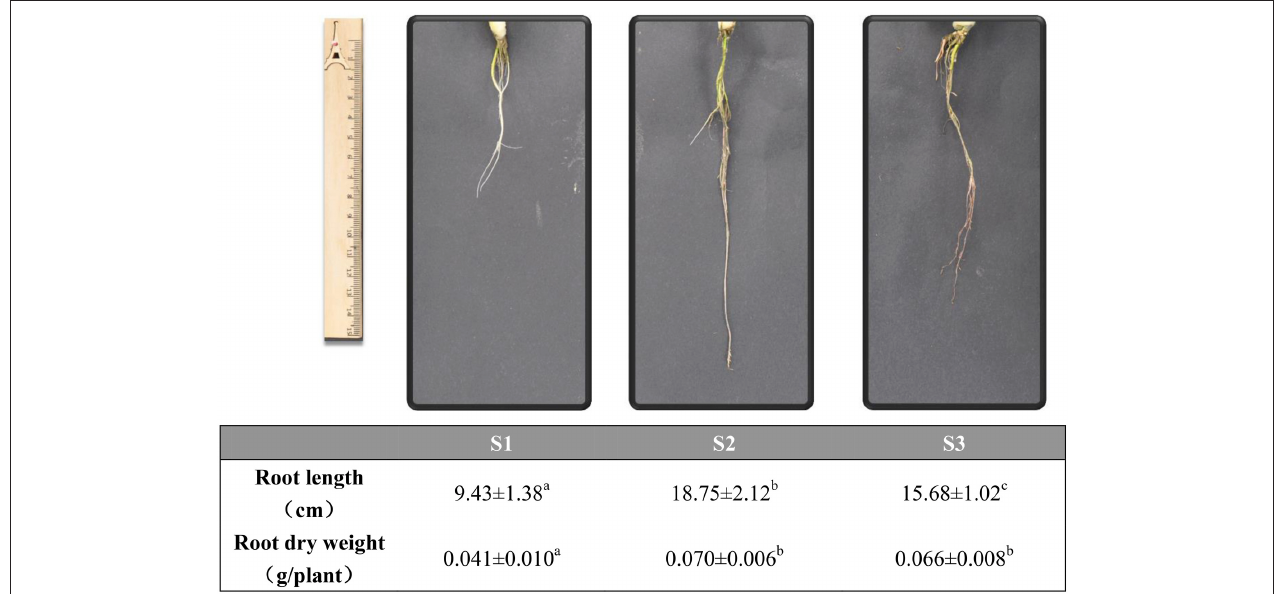
FIGURE 2 | Morphological parameters of poplar roots with different N forms for 21 days. Upper: The picture of the root under different N forms; Lower: Length of roots and the dry weighs of roots. Values are the mean of four replicates ± SE. a, b, and c indicate significant difference based on ANOVA analysis and Duncan’s test ( P < 0.05 ).